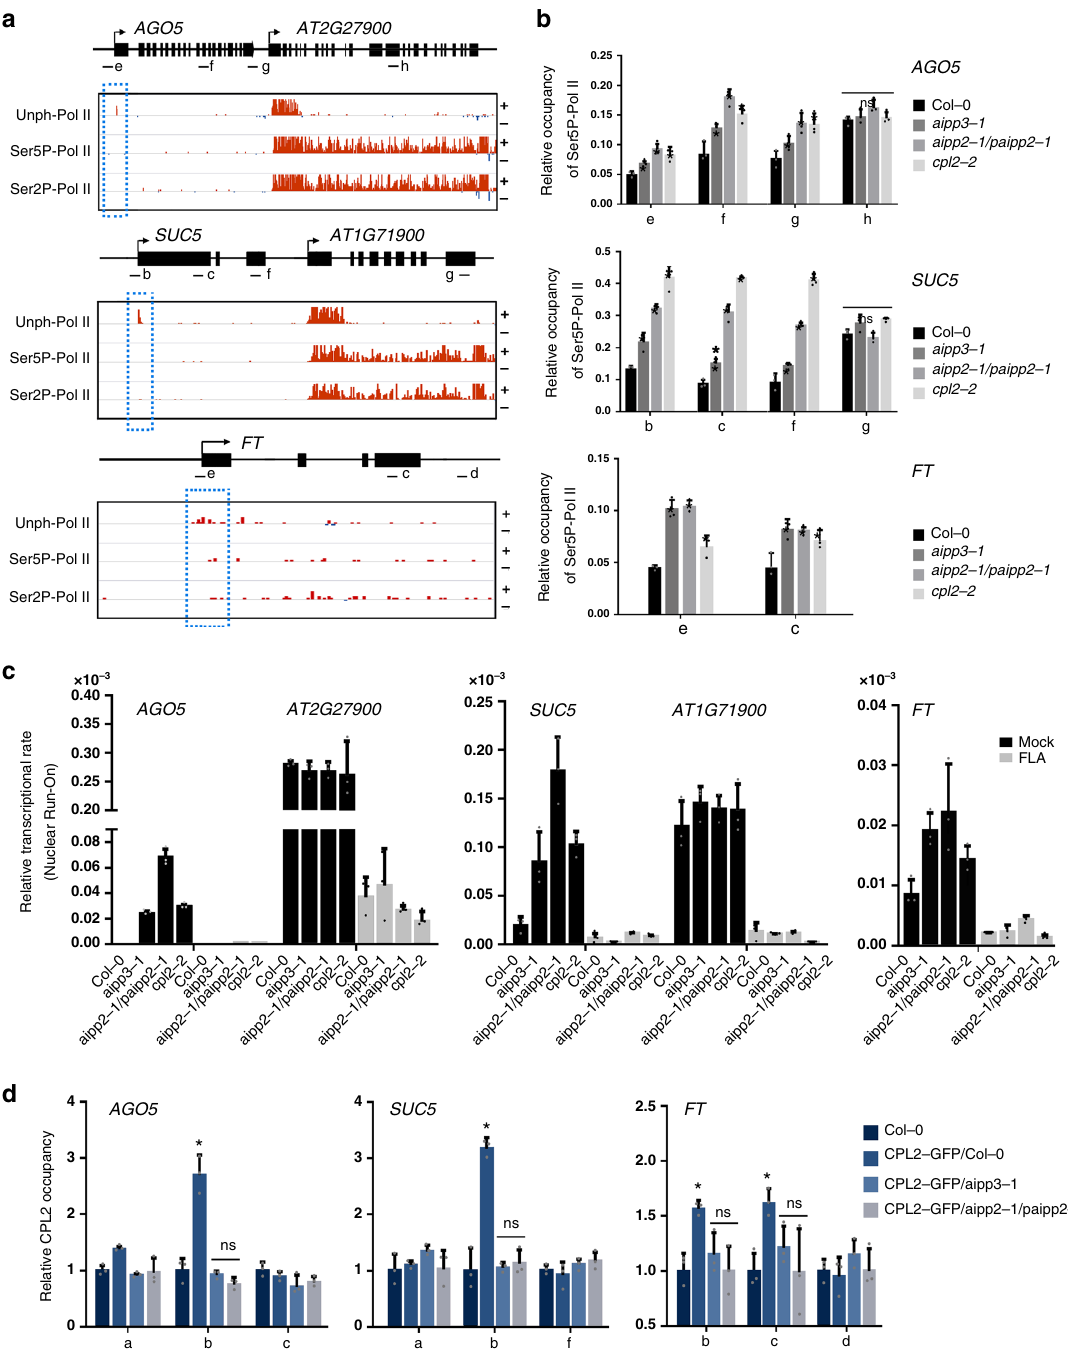
Fig. 7 BPC complex directly connects H3K27me3 recognition with transcriptional repression. a Snapshots showing the occupancies of different Pol II forms on selected target genes using a published Pol II NET-seq database. The red and blue lines indicate the Pol II signals in the plus and minus strands, respectively. The dashed red boxes indicate the occupancies of Pol II on the selected target genes. The black arrows indicate the transcriptional direction. b The ChIP-qPCR validation of the occupancy of Ser5P-Pol II on selected genes in different mutants. The lowercase letters the examined regions (the same below). The occupancy was normalized to the ACT7 . The data are the means ± S.D. of three biological repeats. Unpaired one-tailed t test was performed and * p value < 0.01. ns no signi fi cance. c Nuclear run-on analysis showing the relative Pol II transcription rate at the selected target genes in Col-0 and bpc mutants with or without FLA treatment (mock). AT2G27900 and AT1G71900 genes serve as control genes. The relative transcription rate was normalized to 18 S rRNA. The data are the means ± S.D. of three biological repeats. d CPL2 ChIP-qPCR results showing the relative occupancy of CPL2 at selected target genes in the presence and absence of AIPP3 and AIPP2/PAIPP2. The occupancy was fi rst normalized to AtSN1 and then normalized to Col-0. The data are the means ± S.D. of three biological repeats. Unpaired one-tailed t test was performed and * p value <